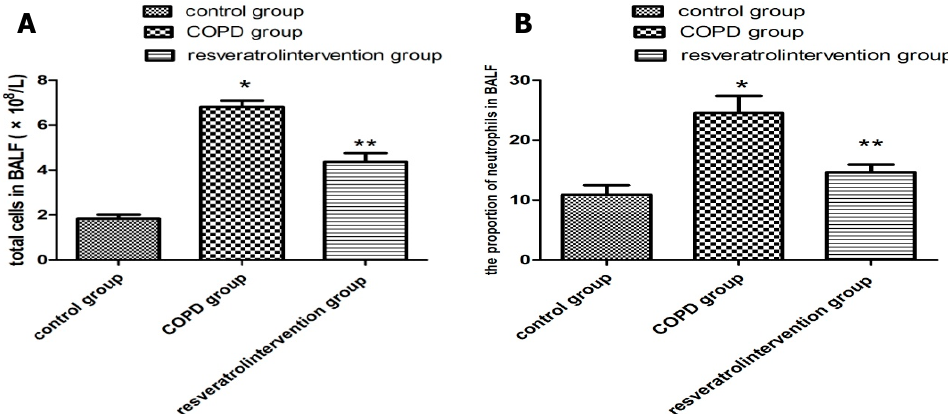
Figure 2. Resveratrol suppressed the recruitment of inflammatory cells into BALF in COPD rats. The numbers of total cells ( A ) the proportion of neutrophils ( B ) in BALF: the COPD with resveratrol group were significantly decreased compared with the COPD model group. Data are mean ± SD (n = 10). * p < 0.05 versus the control group, ** p < 0.05 versus the COPD model group.